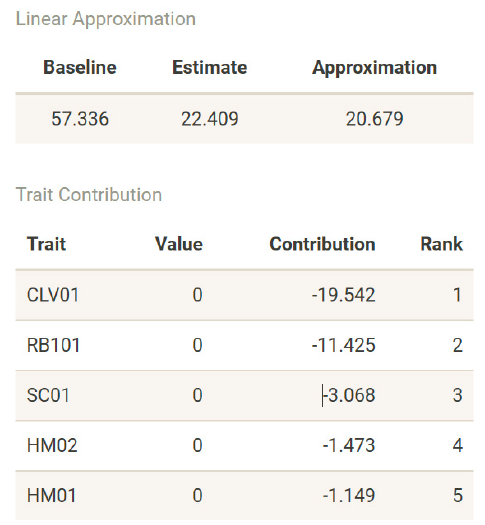
Figure 8. Explanation of an estimate by a linear surrogate model as performed by DRNNAGE